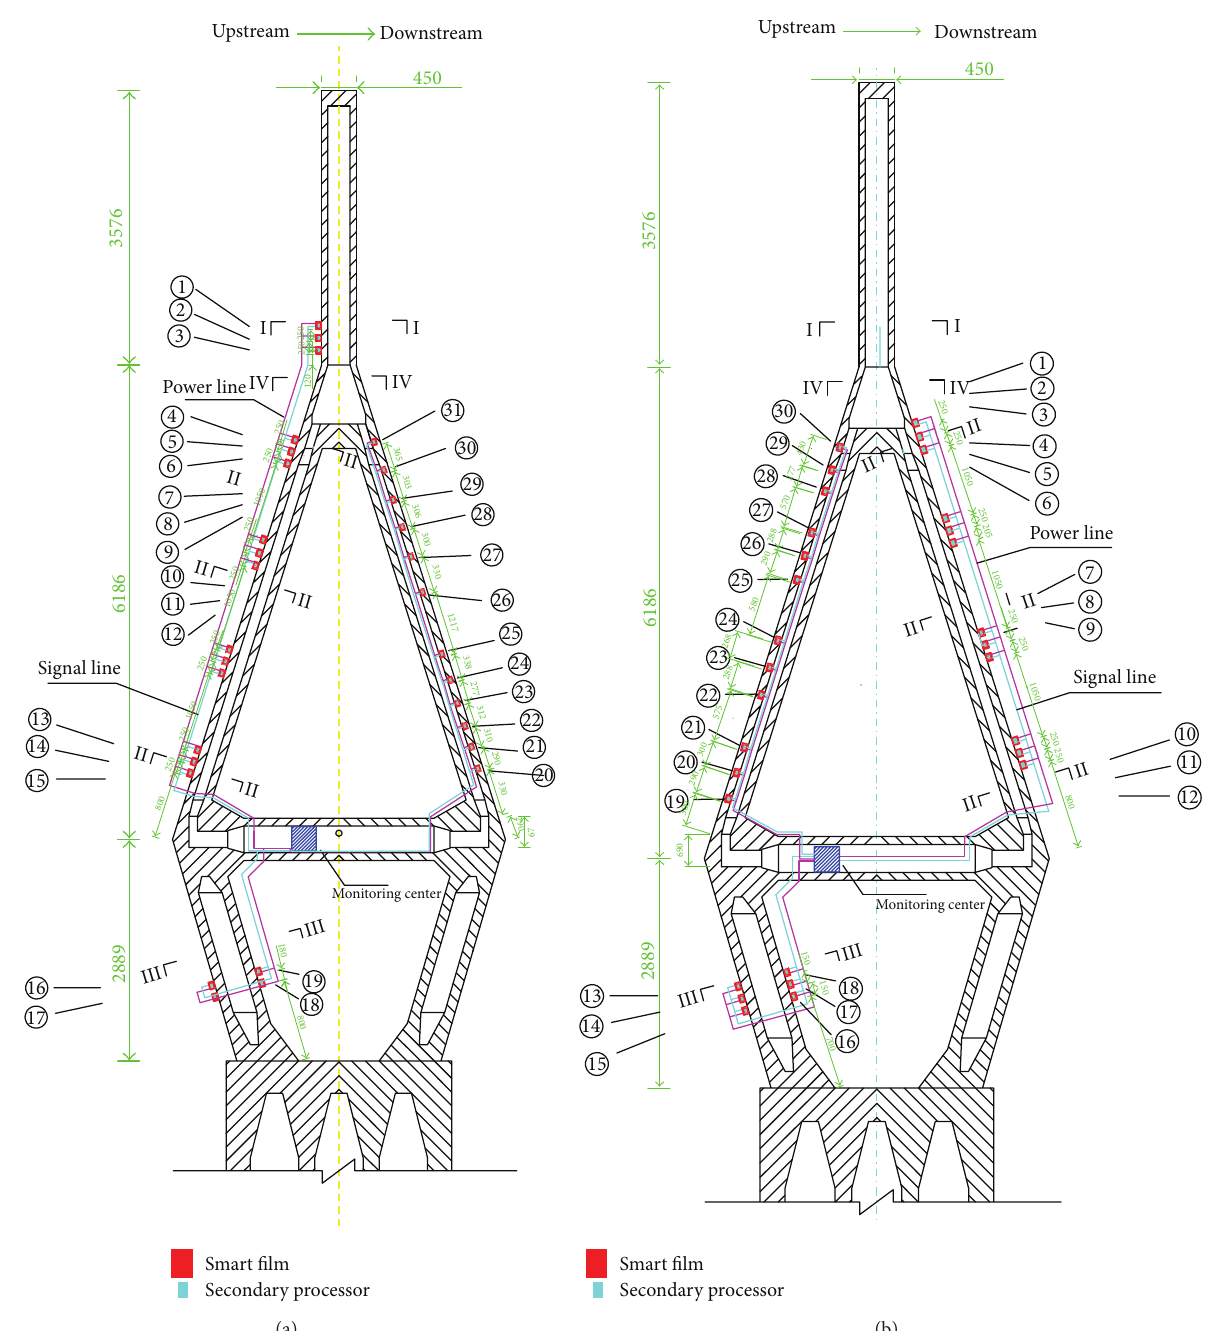
Figure 11: Illustration of sensor installation of tower crack monitoring system: (a) layout of the smart film and the secondary processor in tower no. 1 and (b) layout of the smart film and the secondary processor in tower no. 2.